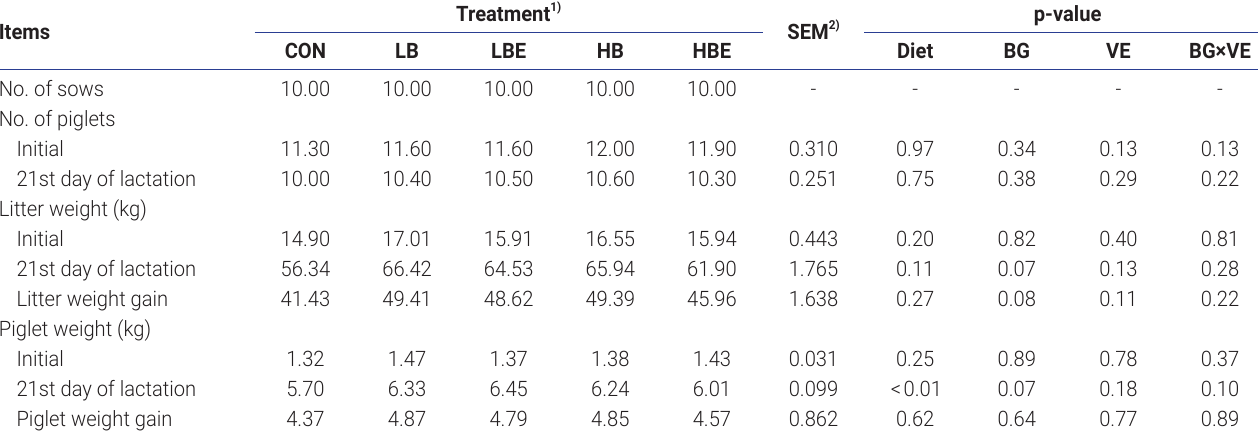
Table 3. Effects of β-glucan with vitamin E supplementation on litter performance